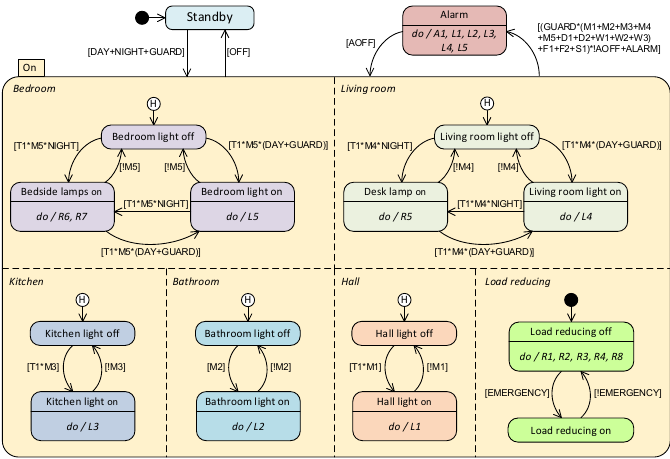
Figure 11. SHS—a UML state machine diagram on the highest hierarchy level.